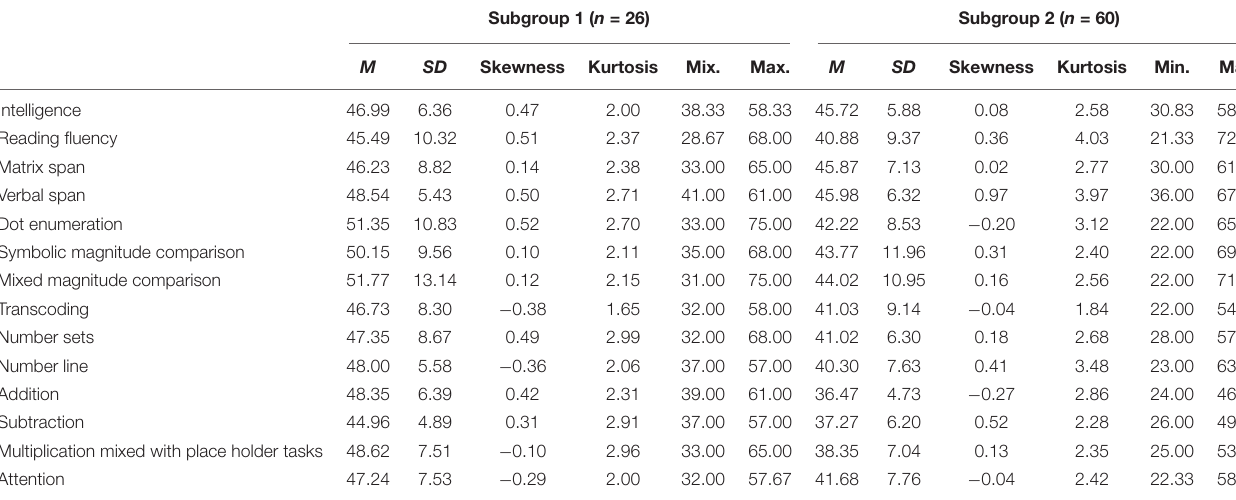
TABLE 3 | Descriptive statistics of the ZAREKI-R sample–clustered by